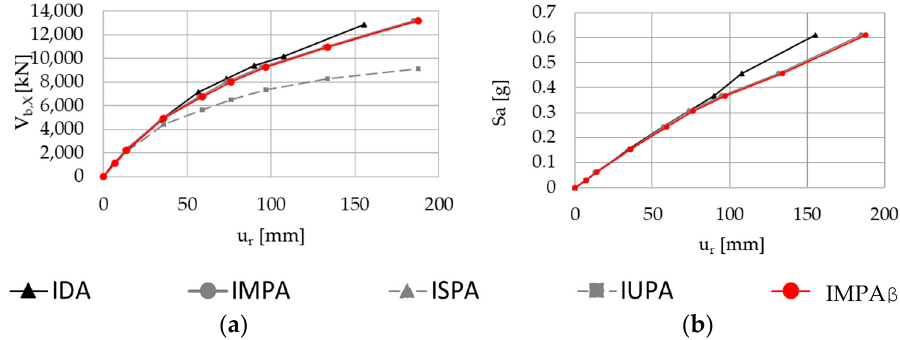
Figure 18. Regular bridge—incremental curve (displacement-intensity) and capacity curves derived